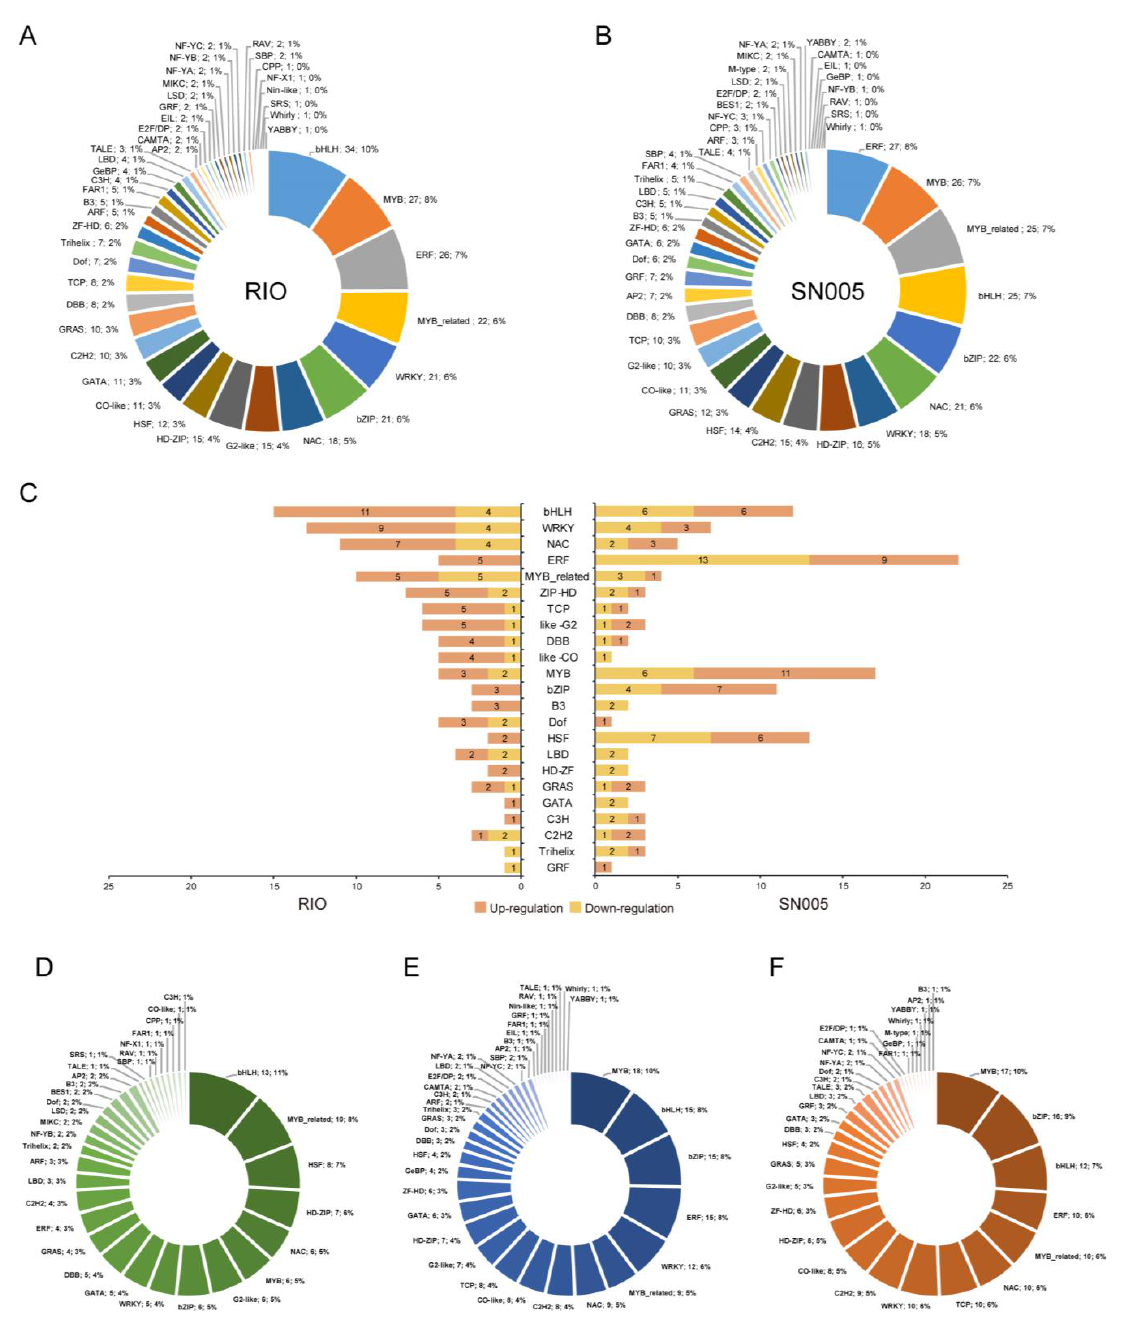
Figure 5. Families of differentially expressed transcription factors in the two genotypes. Distribution in families of differentially expressed transcription factors in the tolerant line RIO ( A ) and the sensitive line SN005 ( B ) at all time points. ( C ) Distribution of up- and downregulated transcription factors in the two genotypes at the early stage (1 and 2 h). Distribution of families of transcription factors in common response gene sets ( D ), RIO-specific response gene sets ( E ), and SN005-specific response gene sets ( F ). Pie charts show the percentage of genes in each transcription factor family.